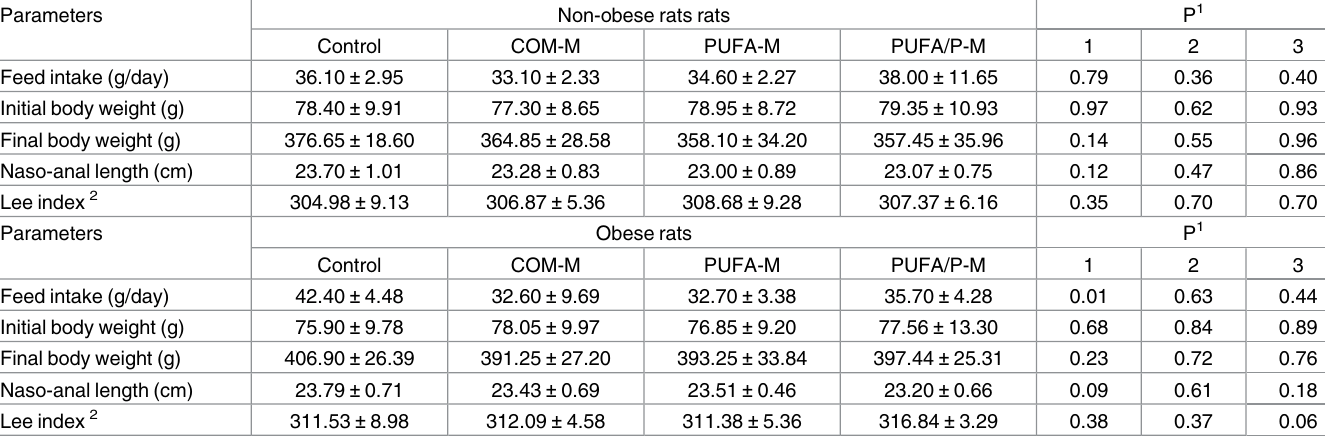
Data are mean ± standard deviation. 1